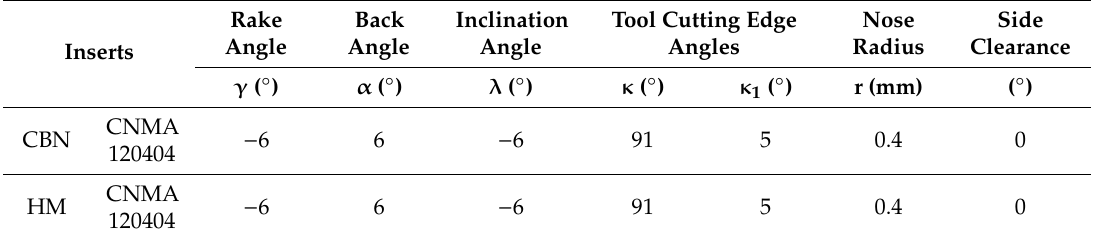
Table 3. Specifications of inserts that were used as tool